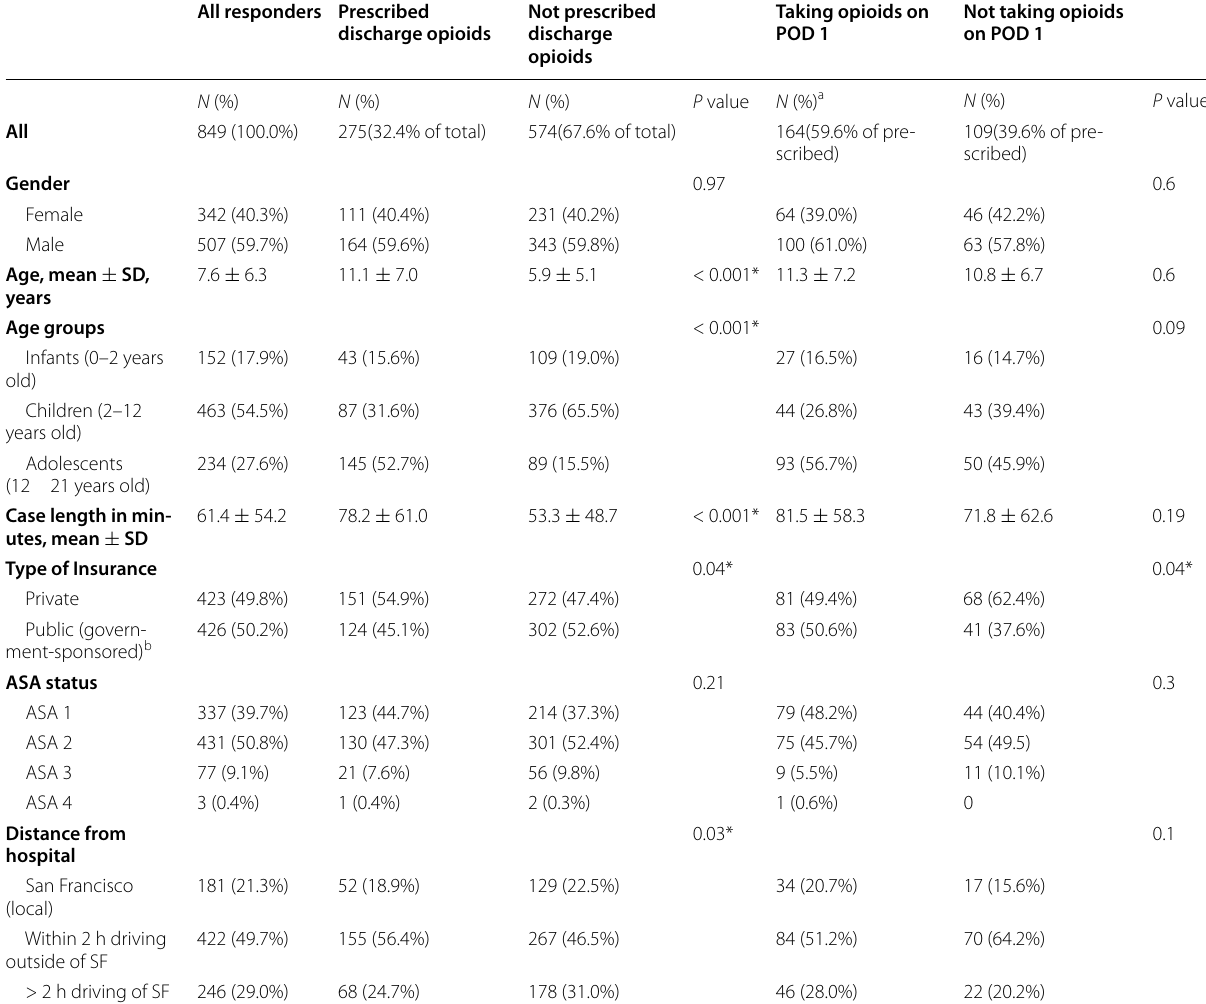
Table 1 Characteristics of the study population and of patients prescribed and not using